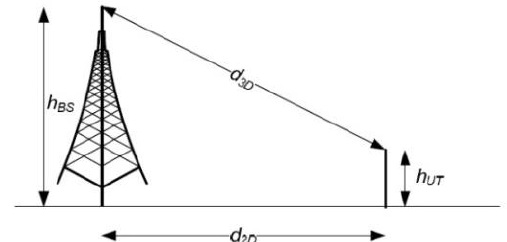
Fig. 29 will define the 3D separation distance.